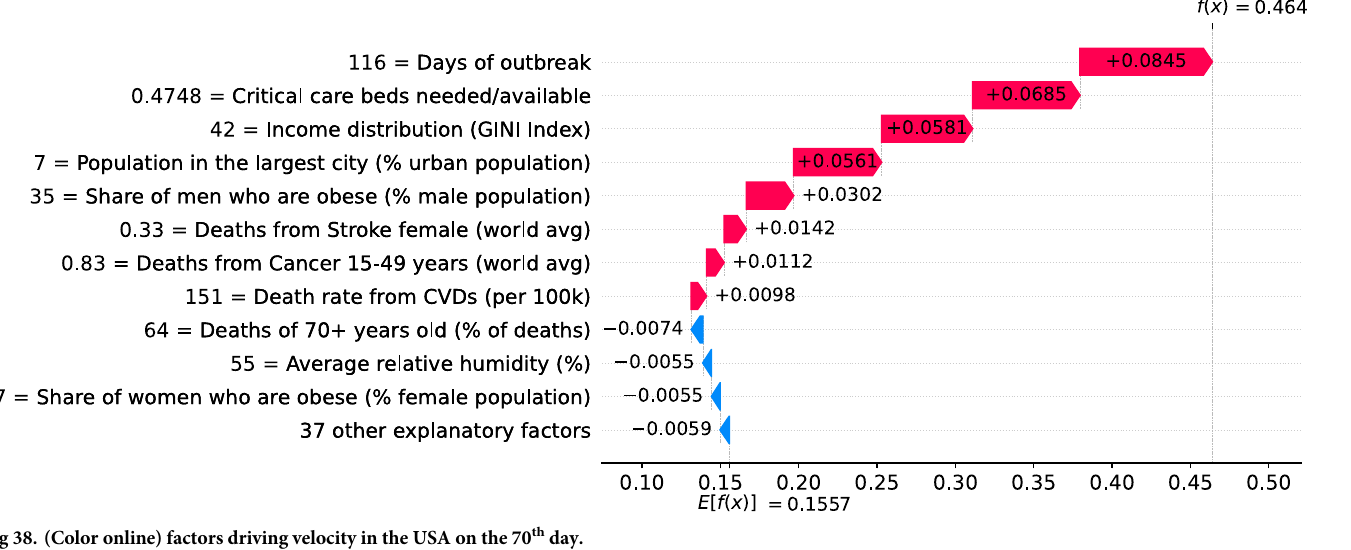
Fig 38. (Color online) factors driving velocity in the USA on the 70 th day.